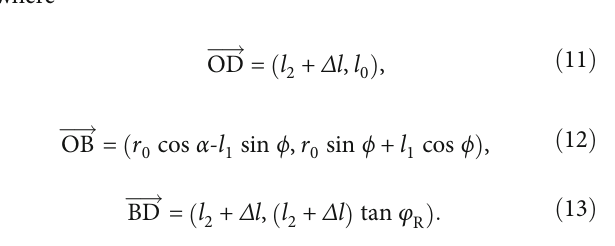
Figure 4: Comparison between ϕ